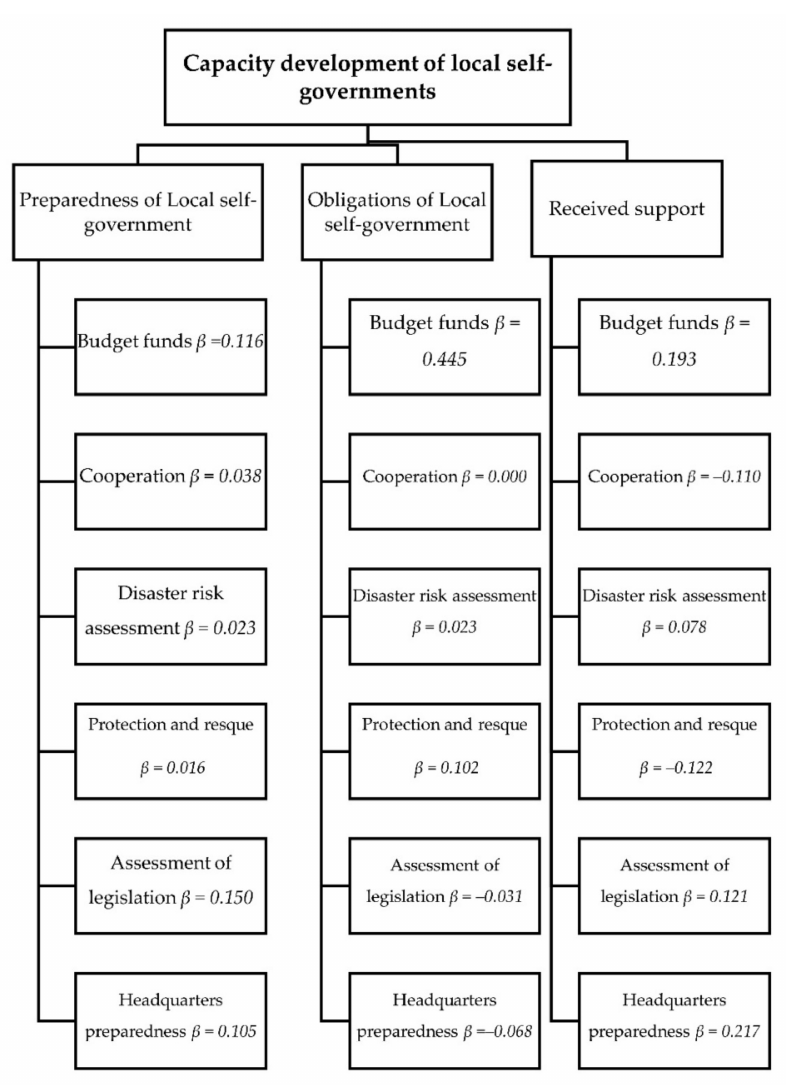
Figure 4. The predictors of the capacity development of local self-governments for